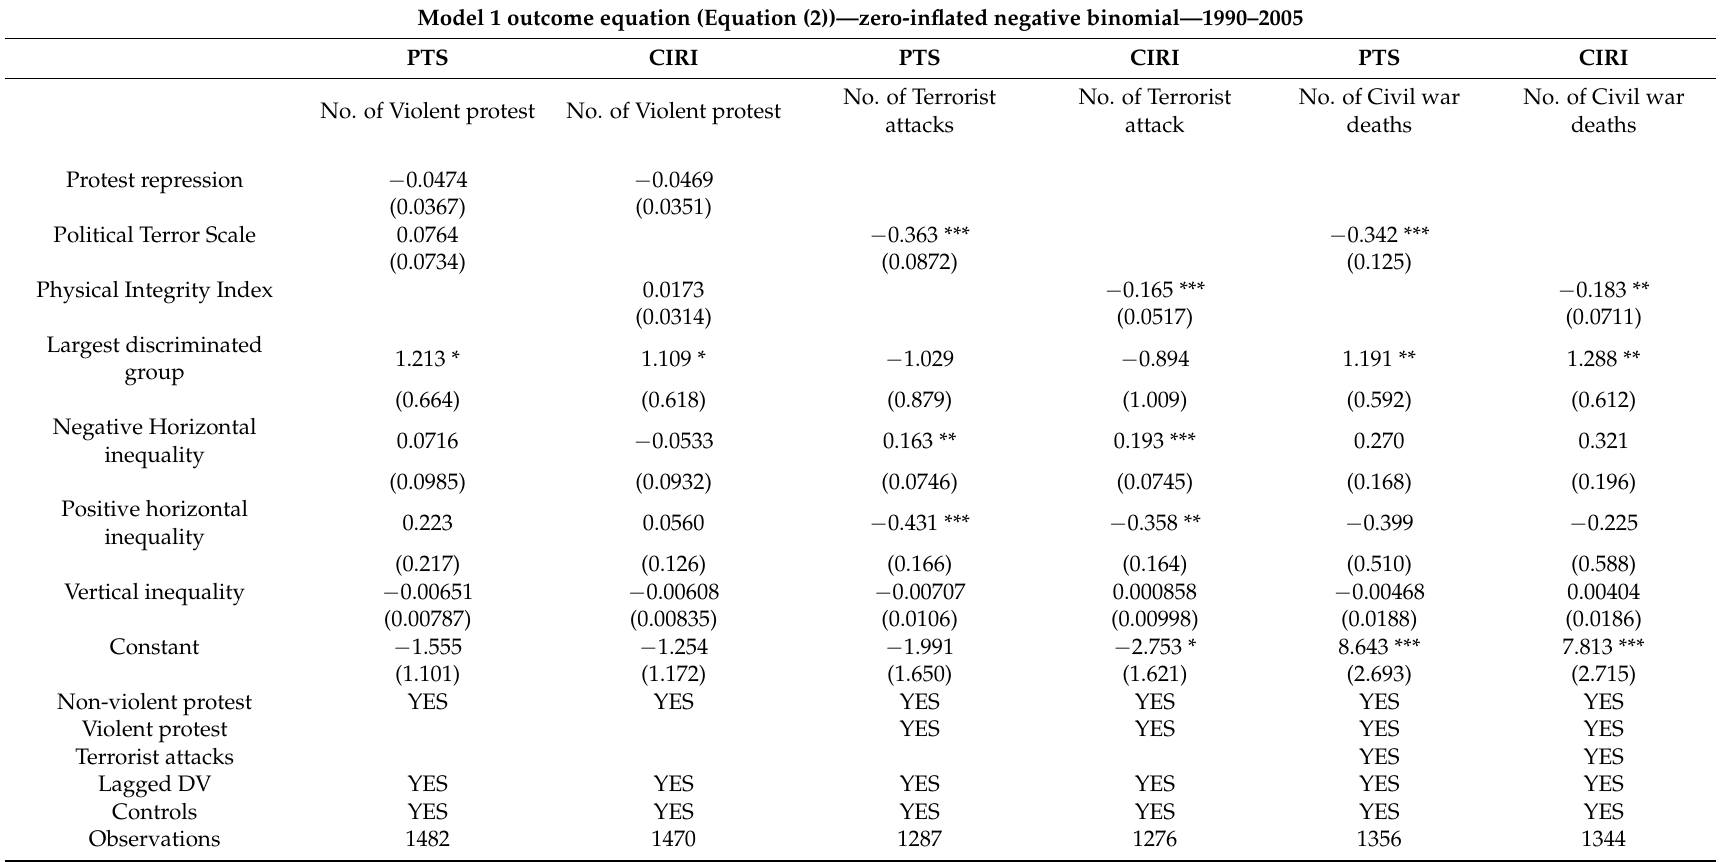
Table 2. Respect for Physical Integrity Rights, Inequality and Internal